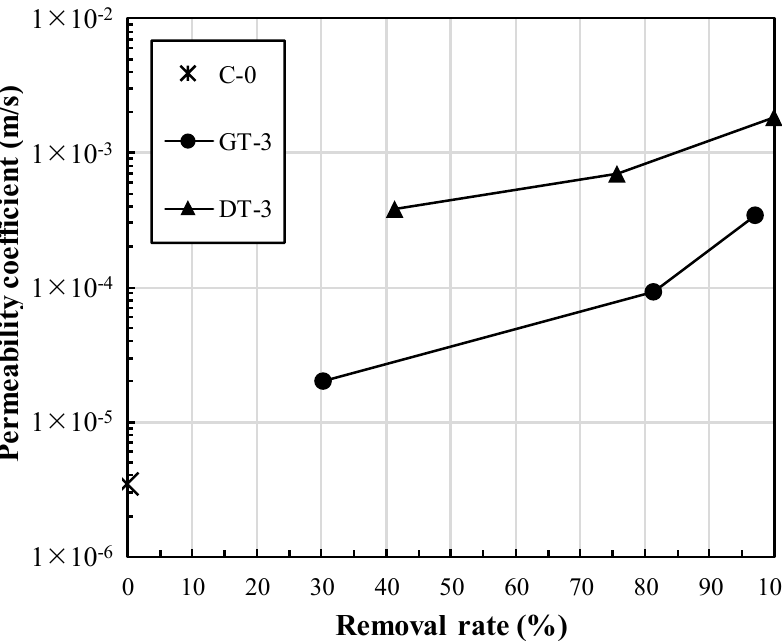
Figure 7. Comparation of the permeabilities of gasoline and diesel.